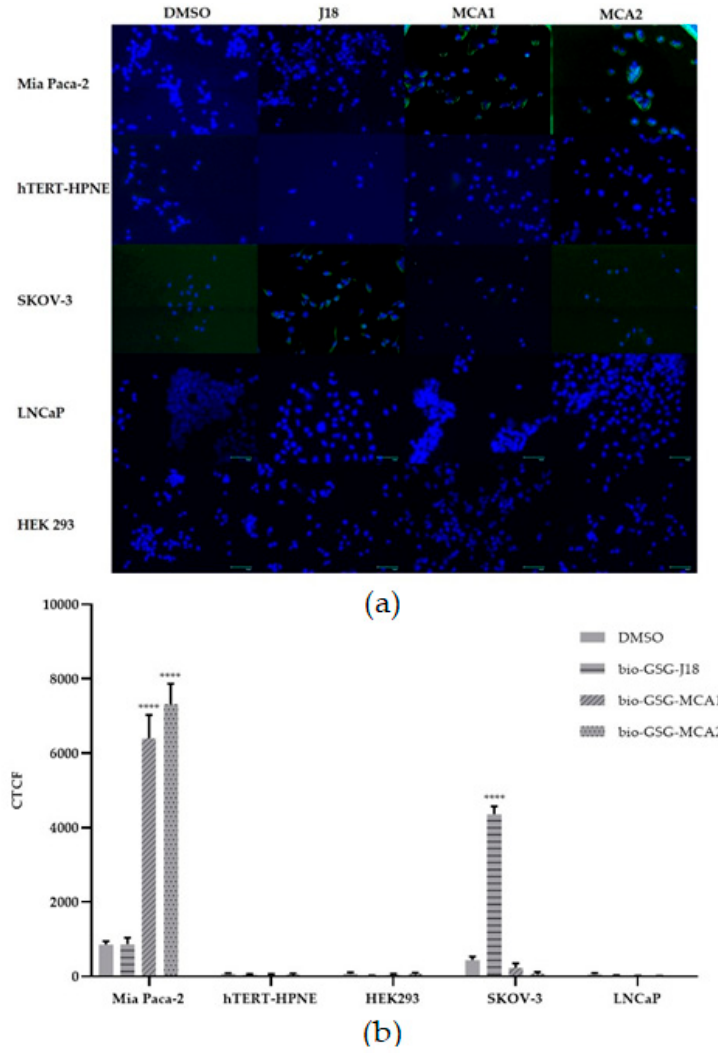
Figure 1. ( a ) Fluorescent microscopy of peptides biotin-GSG-MCA1, biotin-GSG MCA2, or biotin-GSG J18 to Mia Paca-2, hTERT-HPNE, SKOV-3, LNCaP, and HEK 293 cells. Cells were incubated with 10 µM of each peptide, or DMSO (vehicle), and then probed by streptavidin-conjugated fluorescein isothiocyanate (FITC). Cells were further stained with ProLong™ Diamond Antifade Mountant with 4 ′ ,6-diamidino-2-phenylindole (DAPI) and detected using an epifluorescent EVOS FLoid Cell Imaging Station (ThermoFisher Scientific, Waltham, MA, USA). Green (FITC-peptide); blue (DAPI). ( b ) The corrected total cell fluorescence (CTCF) was determined using ImageJ software, and showed that biotin-GSG-MCA1 and biotin-GSG-MCA2 exhibited significantly higher fluorescence to Mia Paca-2 cells (mean±SEM). As expected, ovarian cancer targeting biotin-GSG-J18 showed significantly higher binding to SKOV-3 cells. A p -value of <0.05 was considered statistically significant. **** p < 0.0001. GSG, glycine–serine–glycine; DMSO, dimethyl sulfoxide.